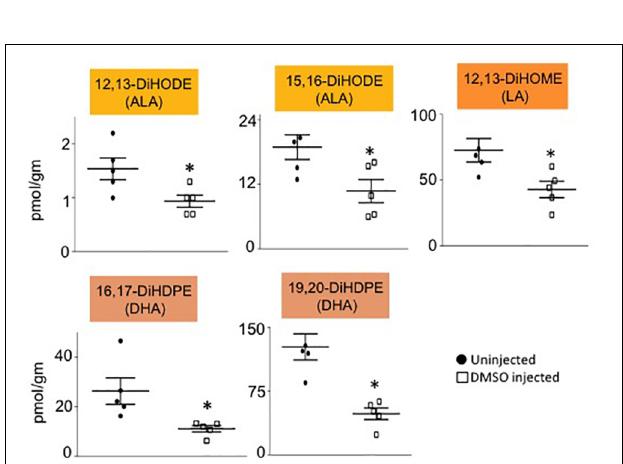
FIGURE 2 | Study design and phenotypic data. (A) Workflow for the study showing the two cohorts of mice used and analyses performed. i.p., intraperitoneal. (B) Average body weights and liver weight as percent of body weight of male C57/BL6N mice at time of sacrifice ( N = 5 per group).